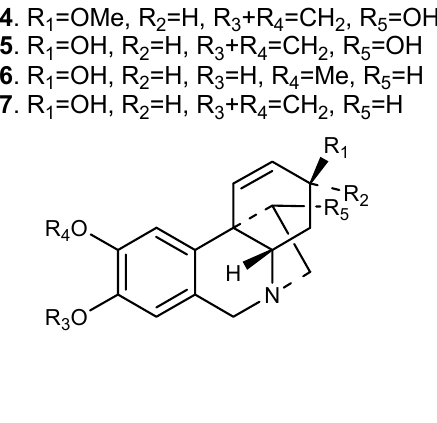
Figure 1. Isolated alkaloids from Hippeastrum papilio